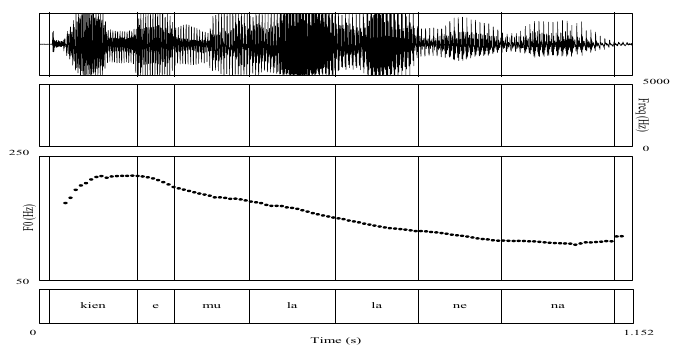
Figure 4. Waveform, spectrogram, and F0 (global falling) contour for ¿Quién emula la nena? (Who emulates the girl?). F0 contour divided according to syllable structure.